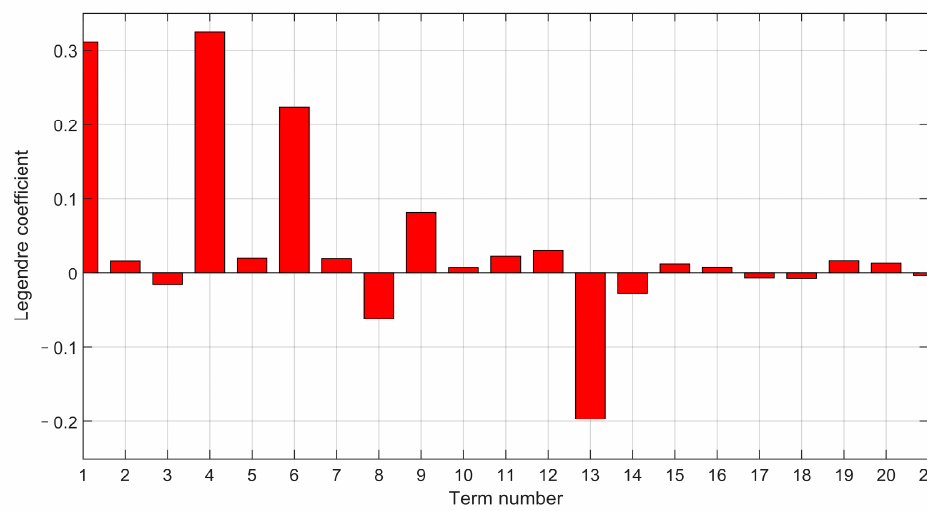
Figure 6. Analysis of the wavefront aberration’s Legendre polynomials. Another function of FR2 in Figure 1 is to compensate for thermally induced depolar- ization [24]. Figure 7a,b show the near fields of a two-pass laser when the FR2 is not placed and when the FR2 is placed and the depolarization effect is